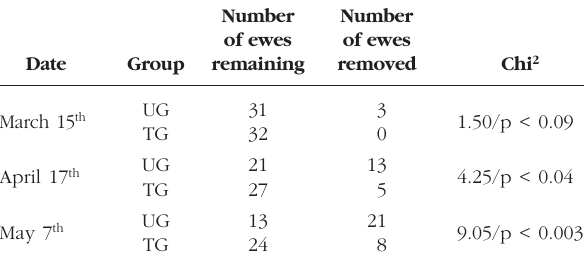
ewes were respectively 86,5 ± 13,1 kg and 88,9 0 ± 15,2 kg and the corresponding mean live weight for